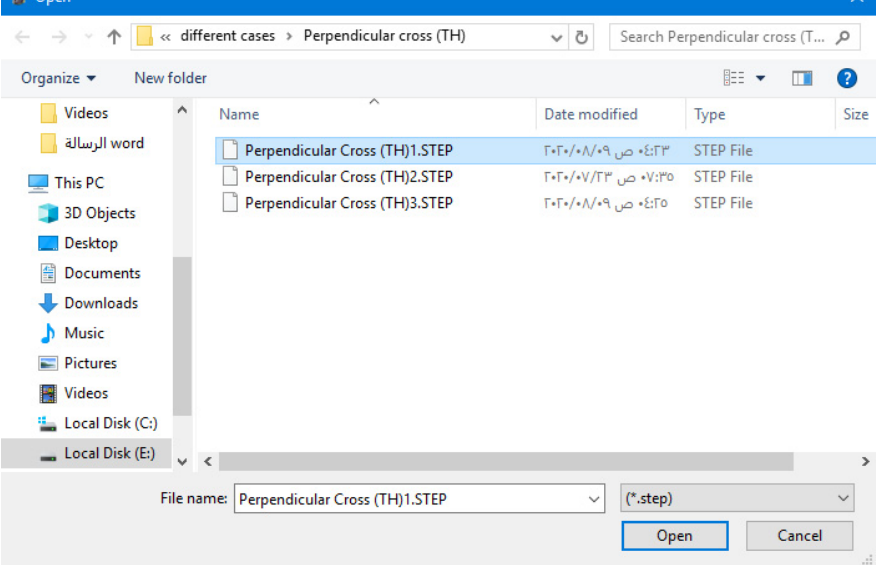
Figure 8. Importing STEP AP-203 file.